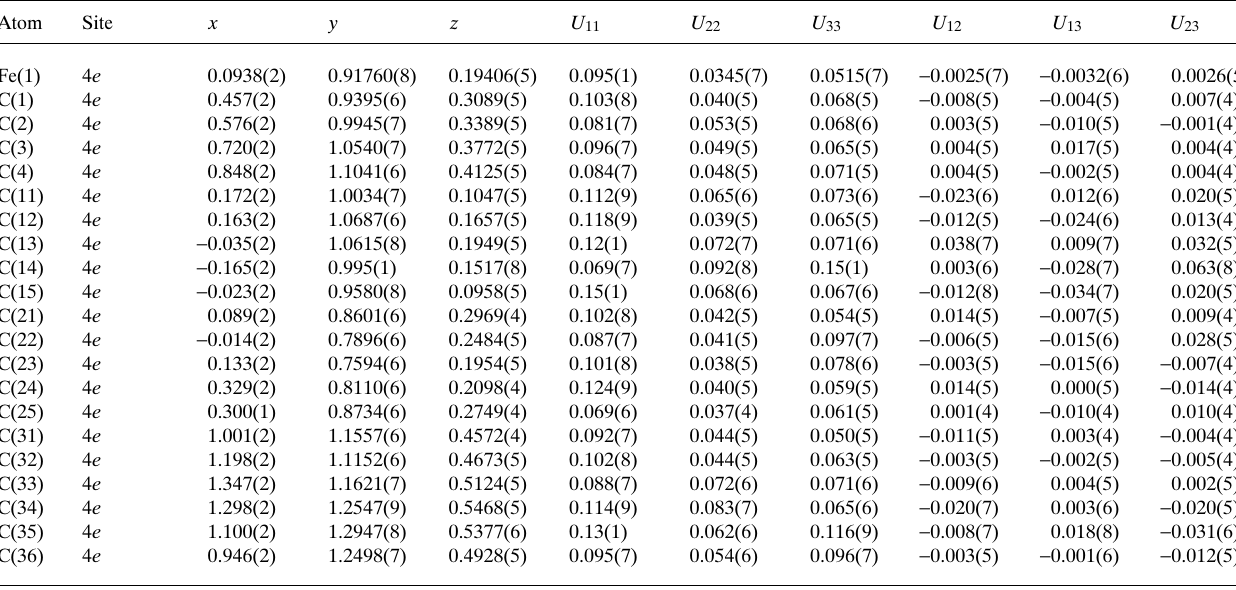
Table 3. Atomic coordinates and displacement parameters (in Å 2 )